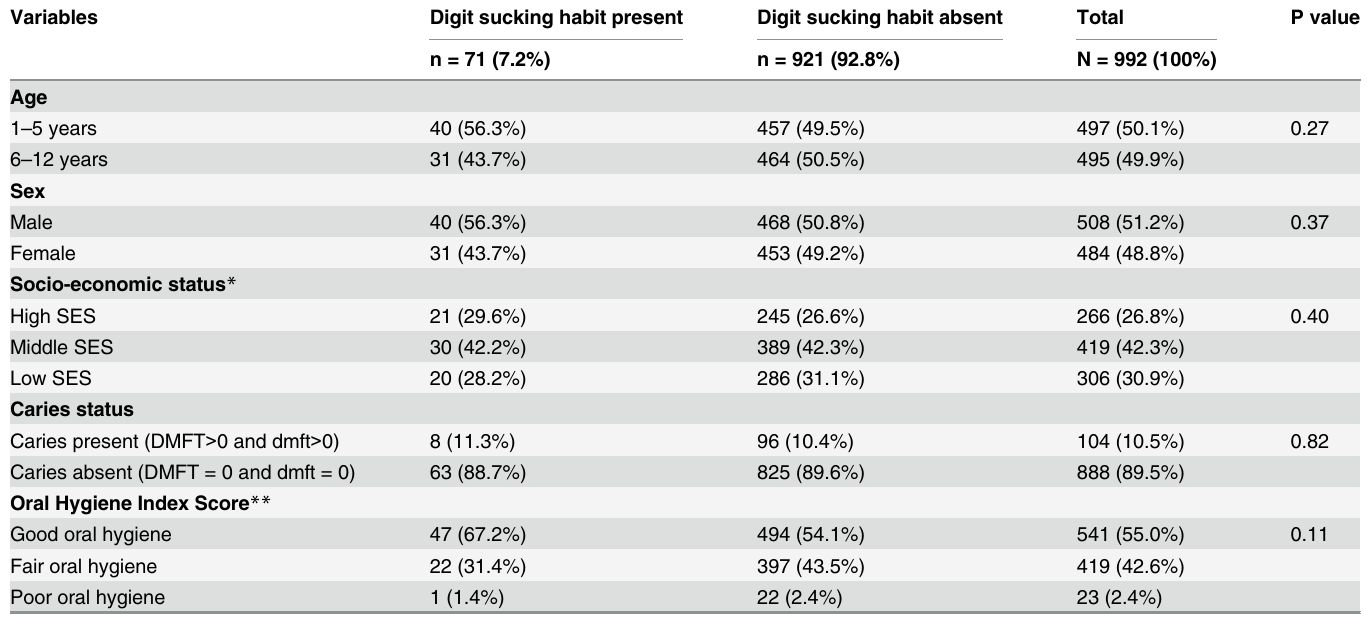
Table 1. Profile of study participants (N = 992).